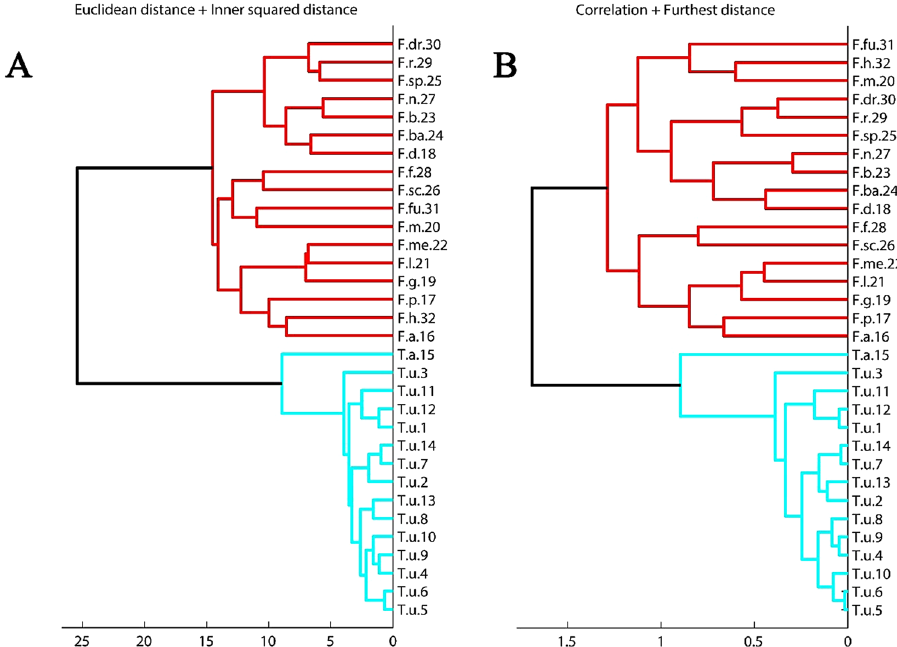
Figure 2. Hierarchical clustering (HC) dendrogram of 32 accessions derived from 46 morphological characteristics. ( A ) Distances between pairs of objects were calculated based on Euclidean distances, and the cluster linkage model utilized the inner squared distance; ( B ) distances between objects (one minus the sample correlation). The cluster linkage model had the greatest distance. In both figures, red lines represent Fargesia accessions, and green lines represent Thamnocalamus accessions. Please see Table 1 for details.